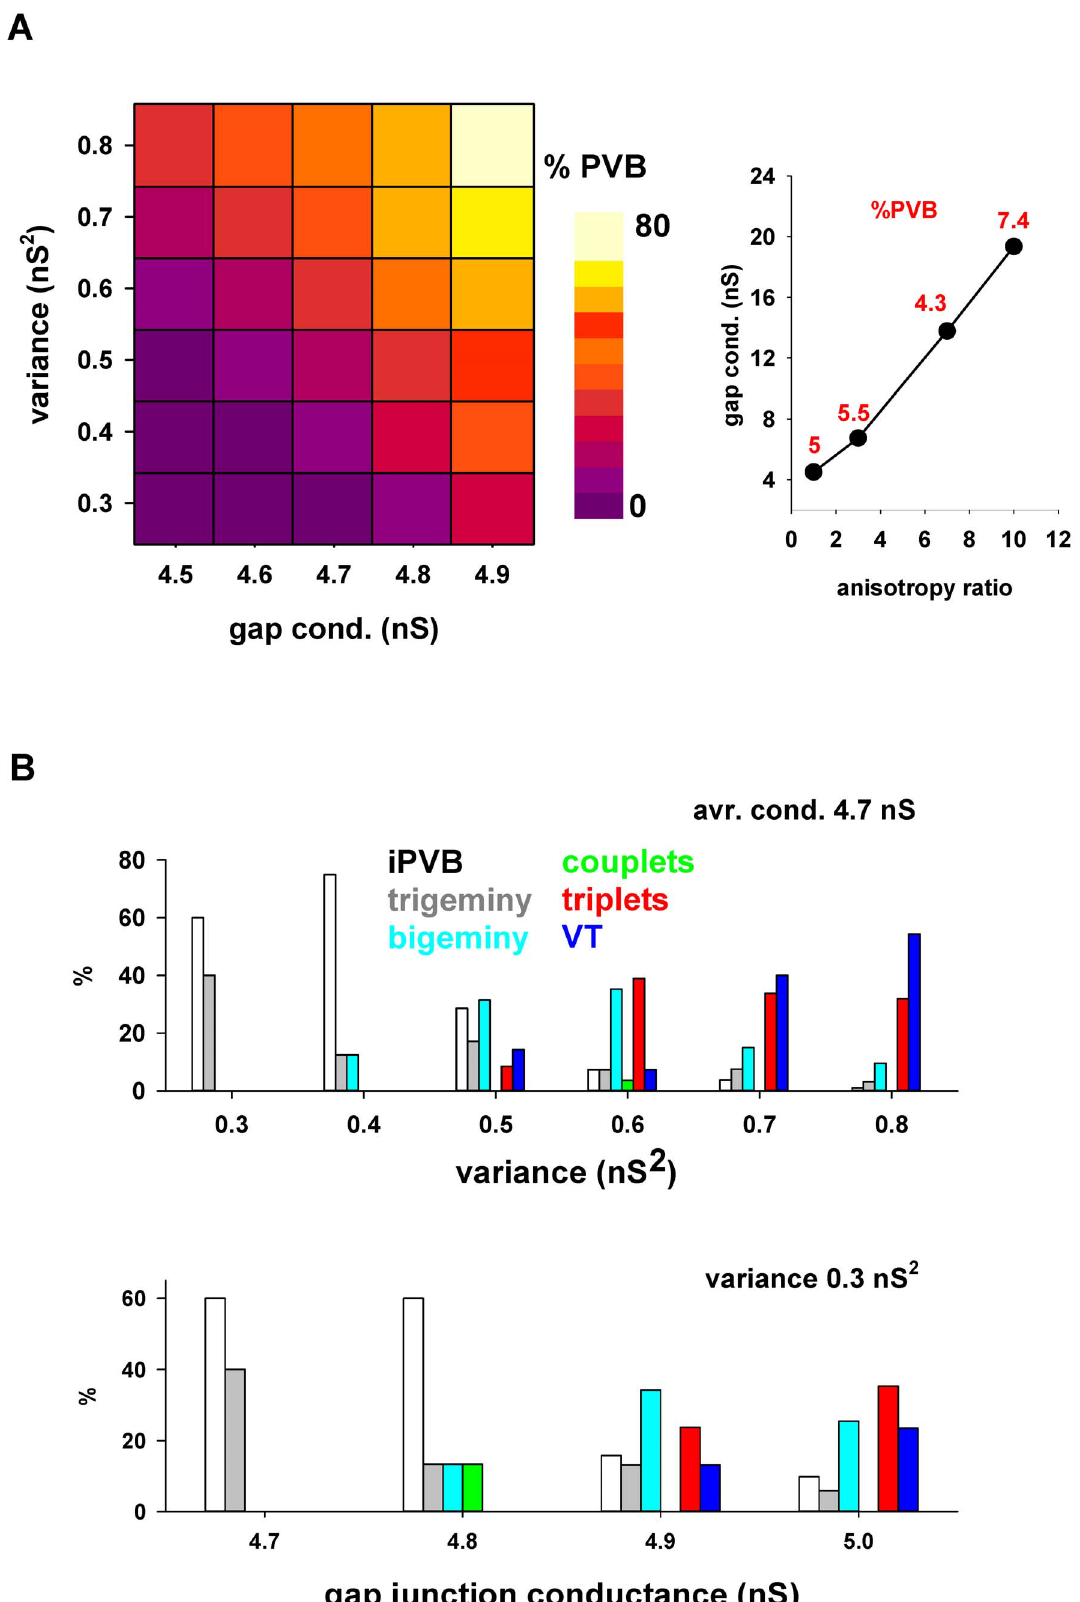
Figure 5. Gap junction modulations and fluctuations inside an ischemic area determine the relative proportion of premature beats. A) Percent of premature beats, with respect to the total number of beats, generated by different average and variance values of the gap junction